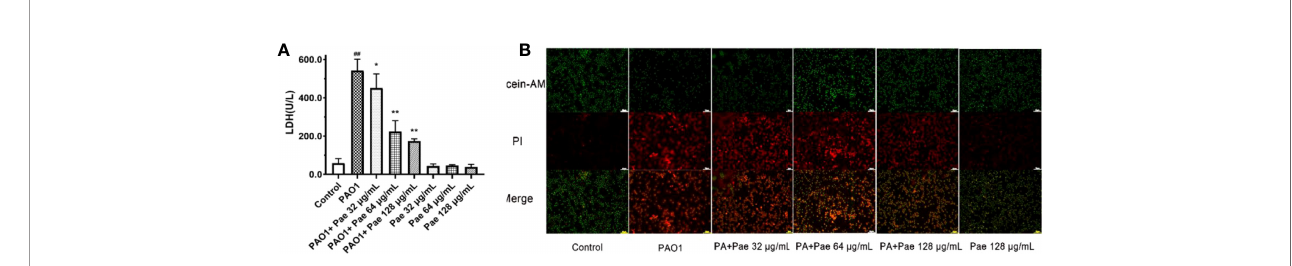
FIGURE 5 | Cell viability were tested in PAO1 infected RAW264.7 (MOI = 25:1) without or with paeonol treatment for 4 h. The Fe 2+ - xylenol orange-based LDH kit (A) and calcein-AM or PI dyes (B) were used in the testing. “ Pae 32 m g/mL ” , “ Pae 64 m g/mL ” , “ Pae 128 m g/mL ” indicate that RAW264.7 cells were pretreated with paeonol for 3 h before infection with PAO1. “ PAO1+Pae 32 m g/mL ” , “ PAO1+Pae 64 m g/mL ” , “ PAO1+Pae 128 m g/mL ” indicate that RAW264.7 cells were infected with PAO1 and treated with paeonol. ## p < 0.01 vs. Control Group, * P < 0.05 or ** P < 0.01 vs the